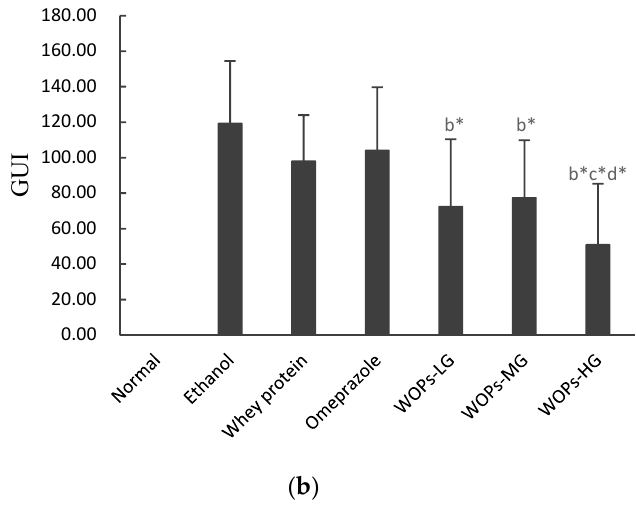
Figure 1. Effect of walnut oligopeptides (WOPs) pretreatment on gross evaluation ( a ) and gastric ulcer index ( b ) of gastric mucosa injury in ethanol-treated rats. N, normal control group; E, ethanol group; P, whey protein group (220 mg/kg body weight); O, omeprazole group (20 mg/kg body weight); WL, WOPs-LG (220 mg/kg body weight); WM, WOPs-LG (440 mg/kg body weight); WH, WOPs-HG (880 mg/kg body weight). Data were presented as mean ± SD ( n = 10); b, c, d stand for in comparison with ethanol group, whey protein group and omeprazole group, respectively; * p < 0.05 was considered to have statistical differences. GUI, Gastric ulcer index; WOPs-LG, 220 mg/kg of walnut oligopeptides group; WOPs-MG, 440 mg/kg of walnut oligopeptides group; WOPs-HG, 880 mg/kg of walnut oligopeptides group.